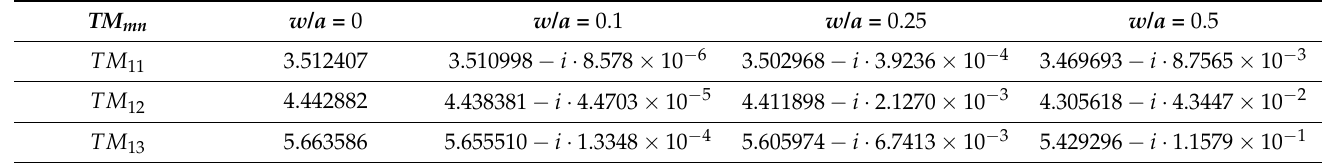
Table 4. Complex eigenvalues γ mn of the isolated slotted rectangular cavity.